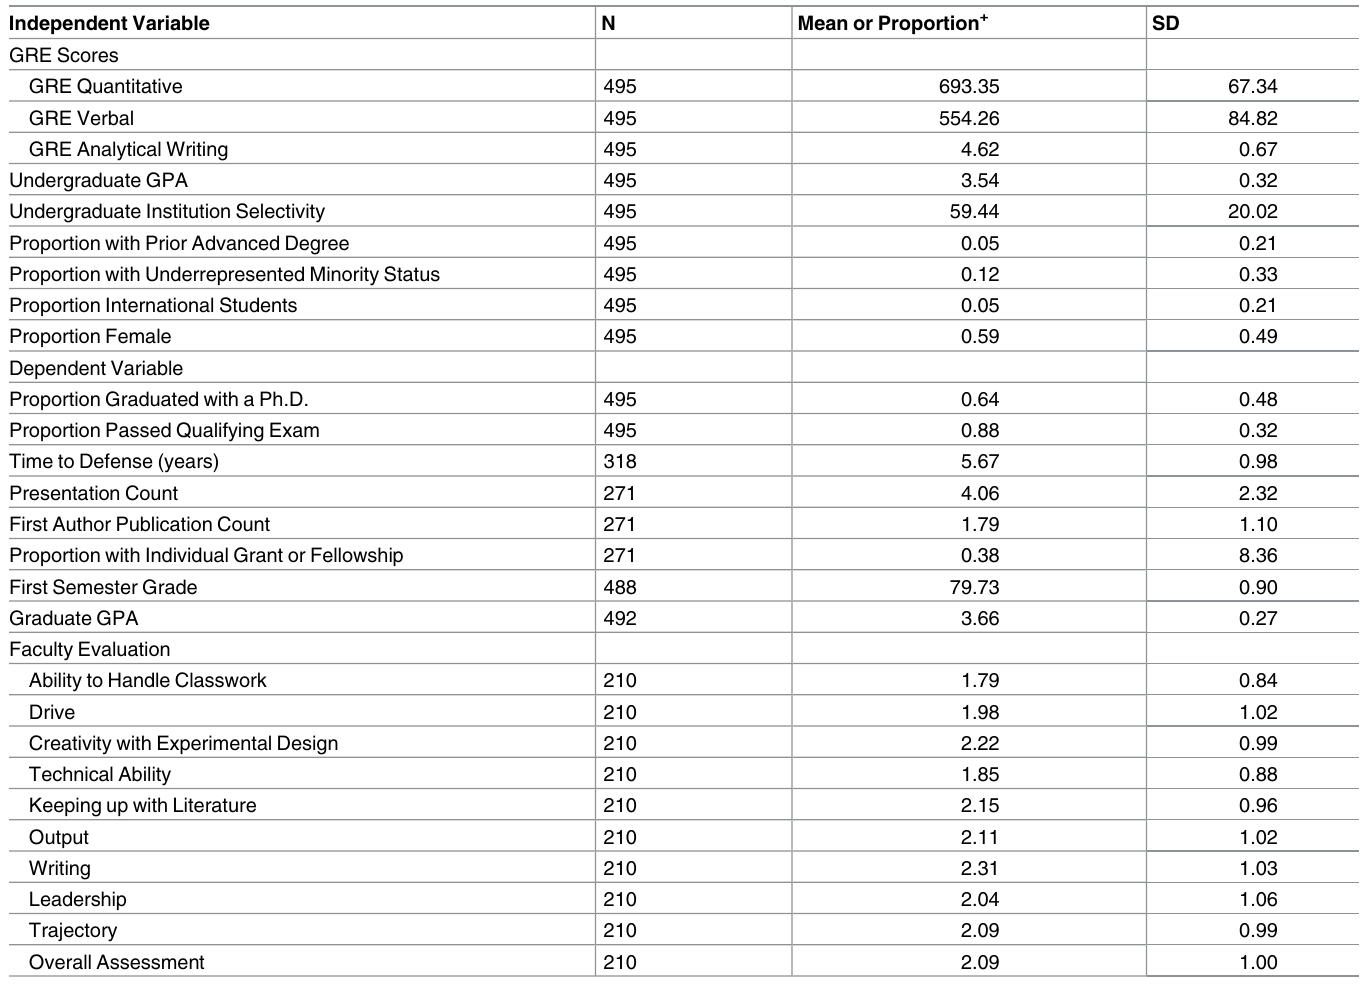
Table 1. SummaryStatistics for each of the Independent and Dependent